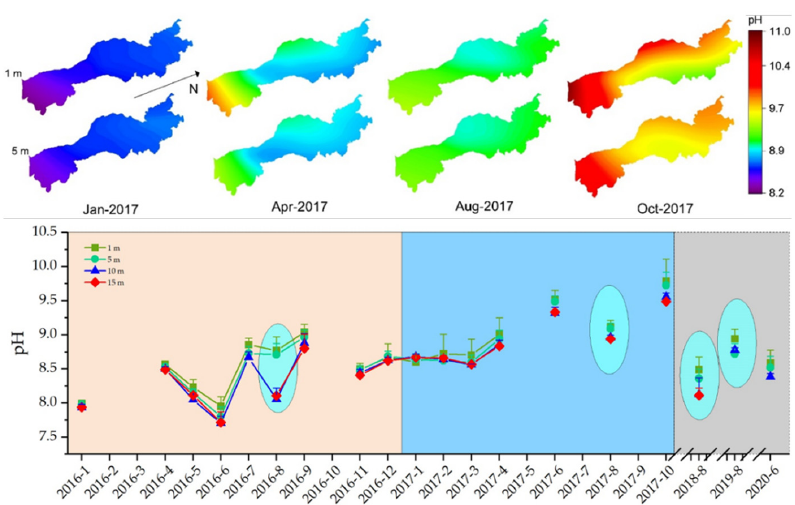
Figure 4. Spatiotemporal changes in pH.